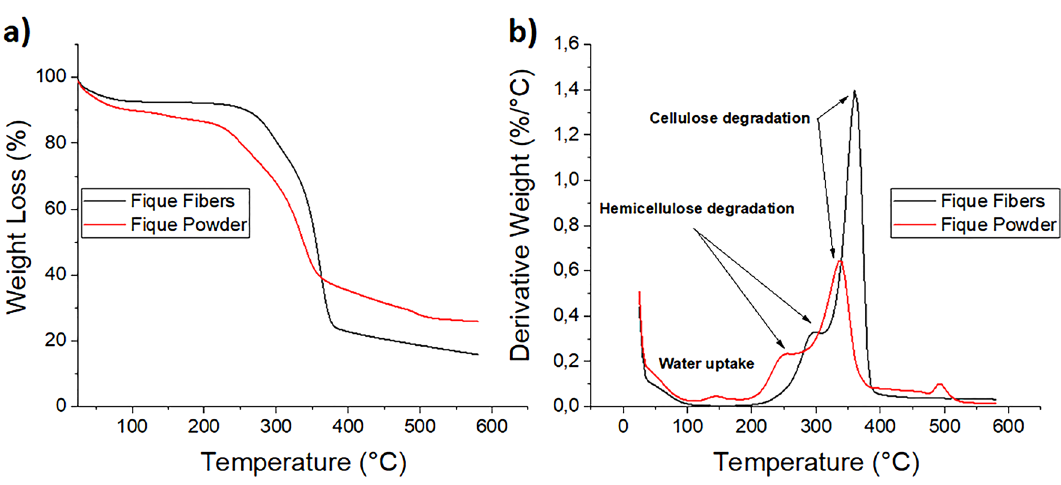
Figure 8. ( a ) TGA and ( b ) DTG of fique Fibers and fique